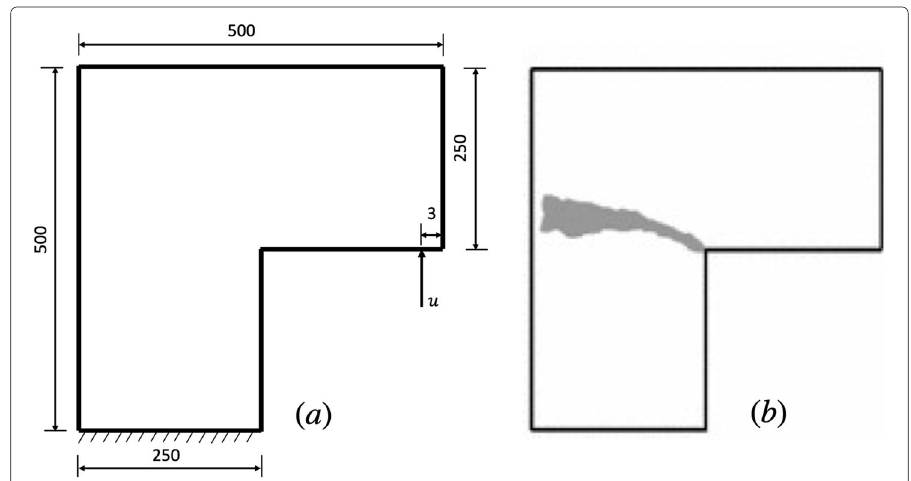
Fig. 12 Geometry, with dimensions in mm, and boundary conditions used in the L-shaped panel simulations are shown in ( a ); The experimental results from (Winkler 2001) are shown in ( b